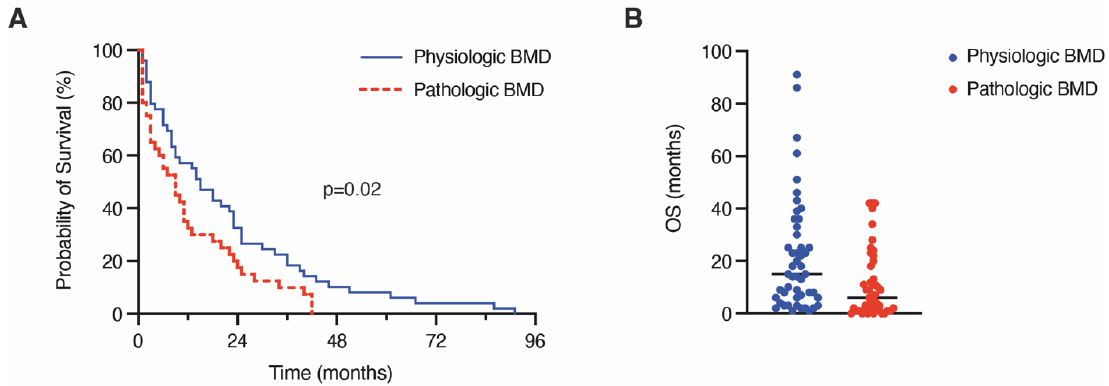
Figure 2. Kaplan–Meier survival curves ( A ) and scatterplot ( B ) depicting OS dependent on patho- logic versus physiologic BMD levels. BM, brain metastasis; BMD, bone mineral